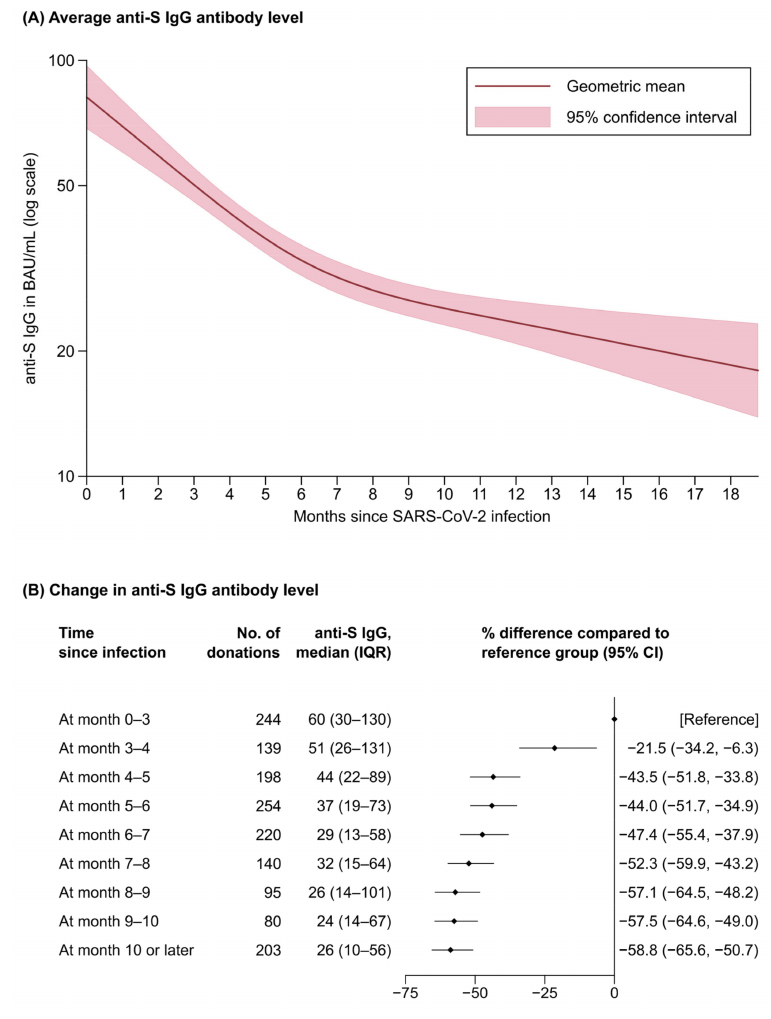
Figure 3. Waning of anti-S IgG antibody levels after SARS-CoV-2 infection among unvaccinated blood donors; Tyrol, Austria; March-September 2021 (n = 1455 a ). Abbreviations: CI, confidence interval; IQR, interquartile range. a 1455 participants were included in the analysis and 113 participants provided repeat anti-S IgG antibody levels. The analysis presented in Panel ( A ) used a mixed model based on restricted cubic splines with three equidistant knots around the range of infection duration, with anti-S IgG antibody values being log-transformed for analysis and estimated coefficients being exponentiated to reflect geometric mean levels at different time points. Panel ( B ) shows the change in anti-S antibody level at different time points since